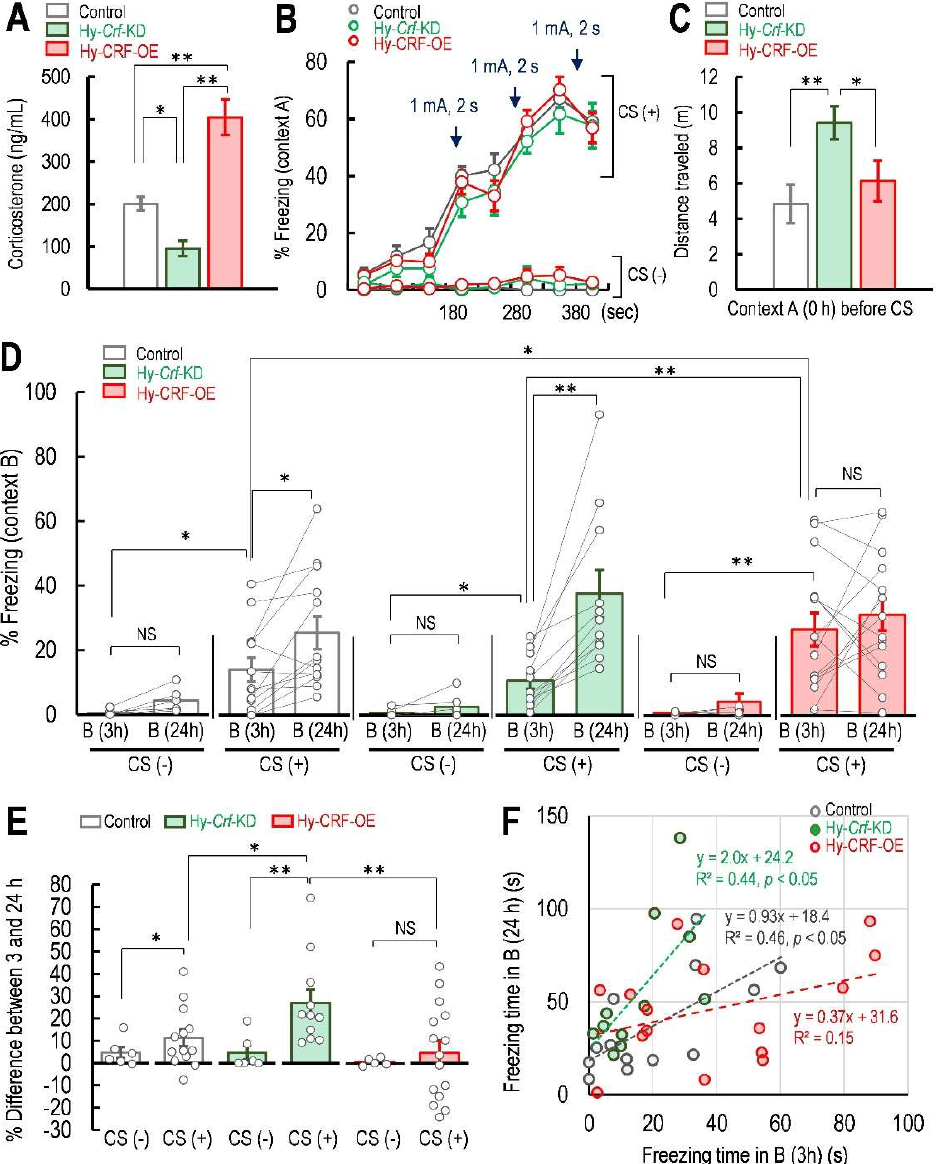
Figure 4. Effect of hypothalamic Crf knockdown or overexpression on freezing level during and after contextual fear conditioning. ( A ) Concentration of plasma corticosterone in control (n = 5), Hy- Crf -KD (n = 5), and Hy-CRF-OE (n = 5) mice during 12:00–14:00 h in the light phase. ( B ) Freezing level during Context A with (+) or without ( − ) the conditioning stimulations (CS). Arrows represent the electric shocks delivered at 180, 280, and 380 s after the mouse was placed in the center of the bottom of Box A. ( C ) Effect of hypothalamic Crf knockdown or CRF overexpression on locomotor activity. Distance (m) traveled in Box A before CS in ABB CS (+) mice group with Hy- Crf -control (n = 13), Hy- Crf -KD ABB (n = 11), and Hy-CRF-OE (n = 15). ( D ) Percentage (%) of freezing level in Context B at 3 and 24 h for ABB CS (+) mice with Hy- Crf -control (n = 13), Hy- Crf -KD ABB (n = 11), and Hy-CRF-OE (n = 15) and ABB CS ( − ) and with Hy- Crf -control (n = 5), Hy- Crf -KD ABB (n = 7), and Hy-CRF-OE (n = 5) at 3 and 24 h after CS. ( E ) Percentage (%) of freezing level differences between 3 and 24 h in ABB CS (+) with the Hy- Crf -control (n = 13), Hy- Crf -KD (n = 11), and Hy-CRF-OE mice (n = 15) and ABB CS ( − ) mice with the Hy- Crf -control (n = 6), Hy- Crf -KD (n = 6), and Hy-CRF-OE mice (n = 6). ( F ) Correlation between freezing level at 3 h vs. 24 h in control (n = 13), Hy- Crf -KD (n = 11), and Hy-CRF-OE mice (n = 15). R 2 is the correlation coefficient. Data are represented as mean ± SEM. * p < 0.05; ** p <